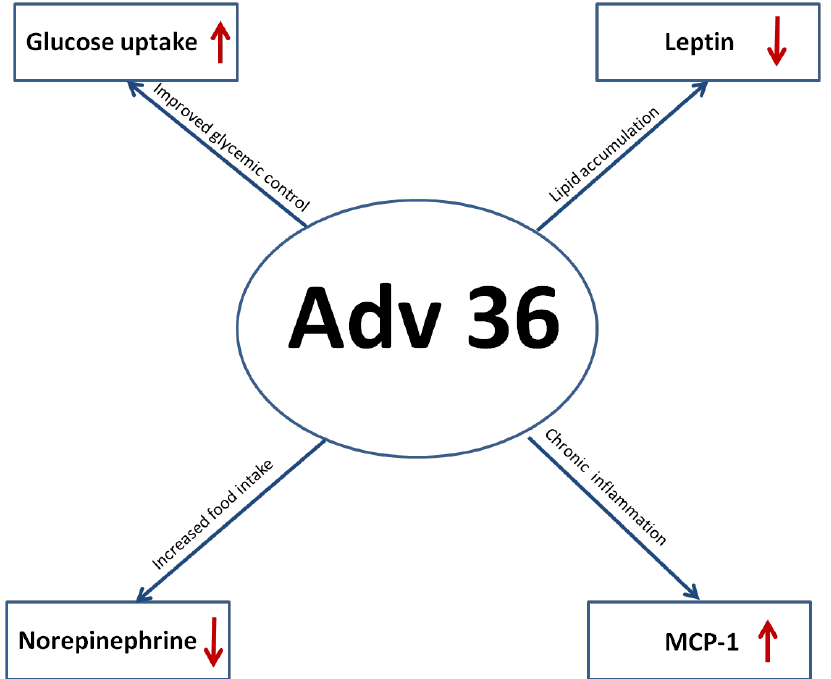
Figure 3. Adv36 and leptin. ( A ) Leptin binding to its receptor (ObRb) activates the associated JAK-2 tyrosine kinase. Leptin inhibits glucose transport through GLUT-2, and activates PI3K. Additionally, Phosphoinositide 3-kinase (PI3K) activation by leptin reduces Cyclic adenosine monophosphate (cAMP) levels and activates the Protein kinase A (PKA) pathway. Leptin can also inhibit the phospholipase C (PLC)/protein kinase C (PKC) pathway; ( B ) Adv36 inhibits leptin production. The results are decreased insulin release and increased lipid accumulation.